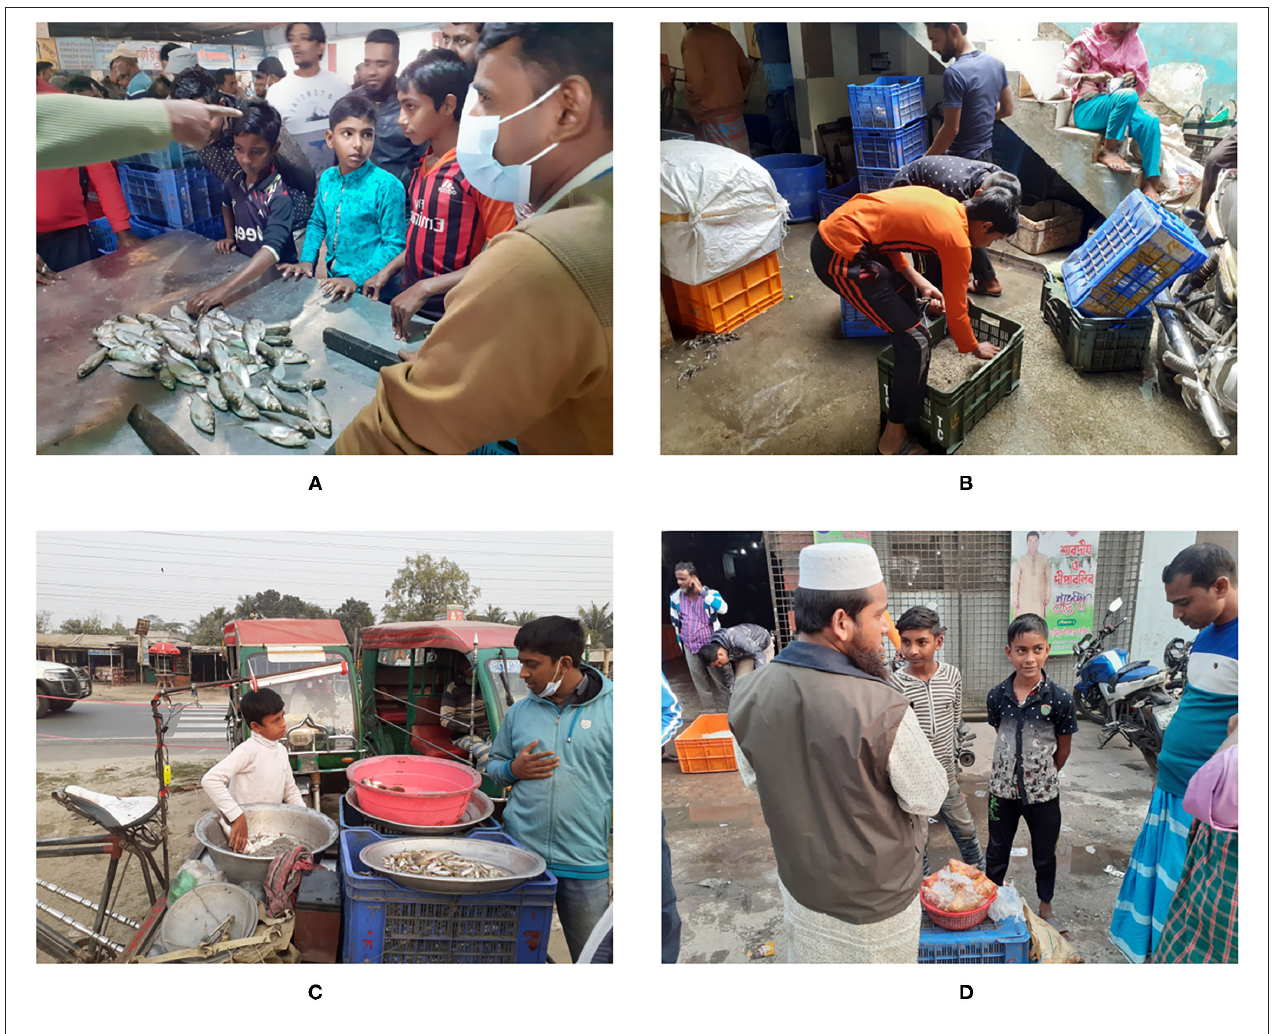
FIGURE 1 | Child entrepreneur contrivance in shrimp value chain of southwest Bangladesh: (A) Active engagement in auction process; (B) grading according to size, species, and/or quality; (C) selling purchased remnant (after grading) shrimp or prawn and other low-cost finfish to the consumers; (D) interacting with consumers to sell by-products (prawn